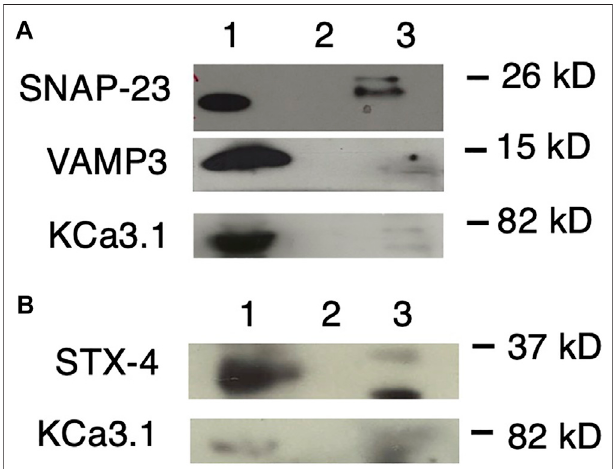
FIGURE 5 | KCa3.1 co-immunoprecipitates (Co-IP) with VAMP3, SNAP-23andSyntaxin-4(STX-4).KCa3.1-BLAPinFRTcellswasusedasbait todetermineproteinassociationswiththeSNAREproteinsVAMP3,SNAP-23 and STX-4. (A) Upper Panel: The blot was probed with anti-SNAP-23 antibody. Lane 1 - SNAP-23 lysate control; Lane 2 - IgG negative control; and Lane3 — pulleddownofSNAP-23( n =5).MiddlePanel:Theblotwasstripped and reprobed with anti-VAMP3 antibody. Lane 1 — VAMP3 lysate control; Lane2-IgGnegativecontrol;andLane3 — VAMP3pulleddownbyCo-IP( n = 6). Lower Panel: The blot was stripped and reprobed with anti-streptavidin antibody. Lane 1 — KCa3.1 lysate control; Lane 2 — IgG negative control; and Lane 3 — KCa3.1 pulled down by Co-IP ( n = 6). (B) Upper Panel: The blot was probed with anti-STX-4 antibody. Lane 1 — STX-4 lysate control; Lane 2 — IgG negative control; and Lane 3 — STX-4 pulled down by Co-IP (band is running high, n = 6). Lower Panel: The blot was stripped and reprobed with anti- streptavidin antibody to detect KCa3.1. The KCa3.1 band is diffuse likely due the membrane being stripped. Lane 1 — KCa3.1 lysate control; Lane 2 — IgG negative control; Lane 3 — KCa3.1 pulled down by Co-IP ( n = 6). These data suggest protein associations occur between KCa3.1 and VAMP3, SNAP-23 and